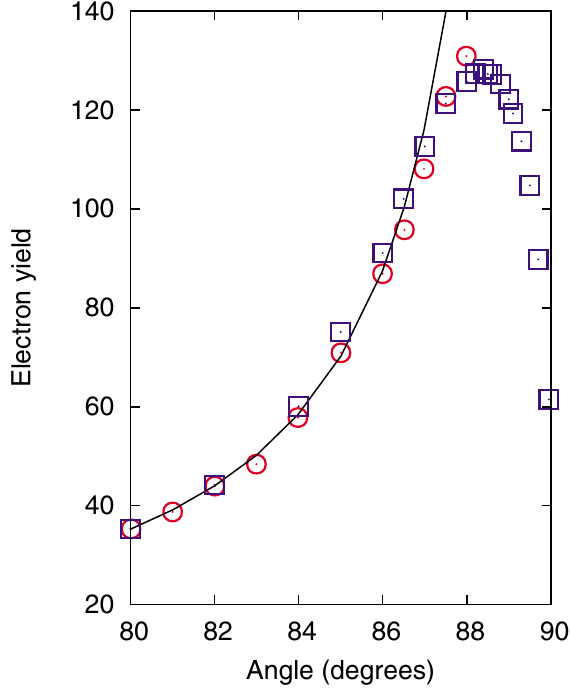
FIG. 3. (Color) The measured (red circles) and simulated (blue squares) electron yields as a function of angle of incidence of the ion measured from the surface normal for 1.0 MeV potas- sium hitting stainless steel. The simulations used d The simulation values are normalized to match the measured yield at the least grazing angle ( 80 (cid:10) in this case). The rms difference between simulated and measured yield is 3%.